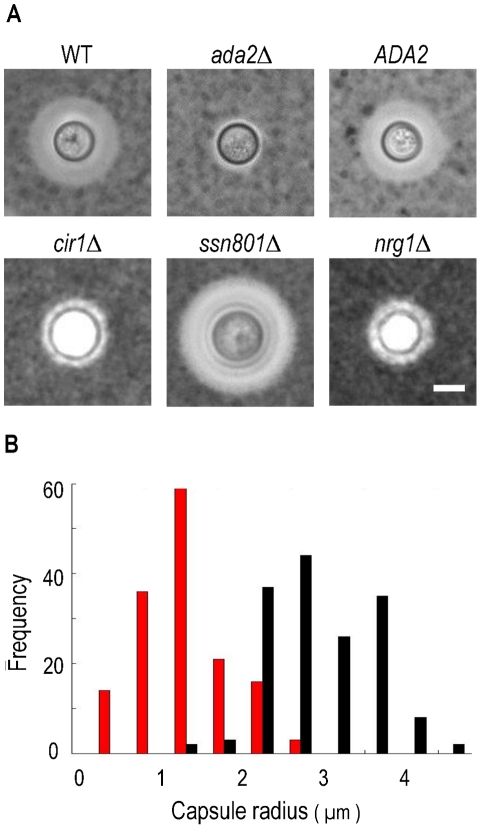
Cells lacking ADA2 display reduced capsule size under inducing conditions.Panel A, negative staining with India ink of KN99α cells (WT), the indicated deletion strains, and the complemented ada2Δ mutant (ADA2). All images are at the same magnification. Scale bar, 5 µm. Panel B, histogram of capsule size for the ada2Δ mutant (red) and WT (black) populations. Capsule radius is represented in microns.